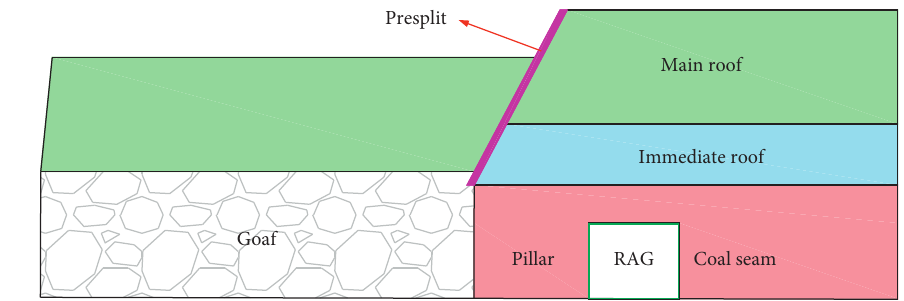
Figure 16: Roof structures over the RAG after presplitting blasting in